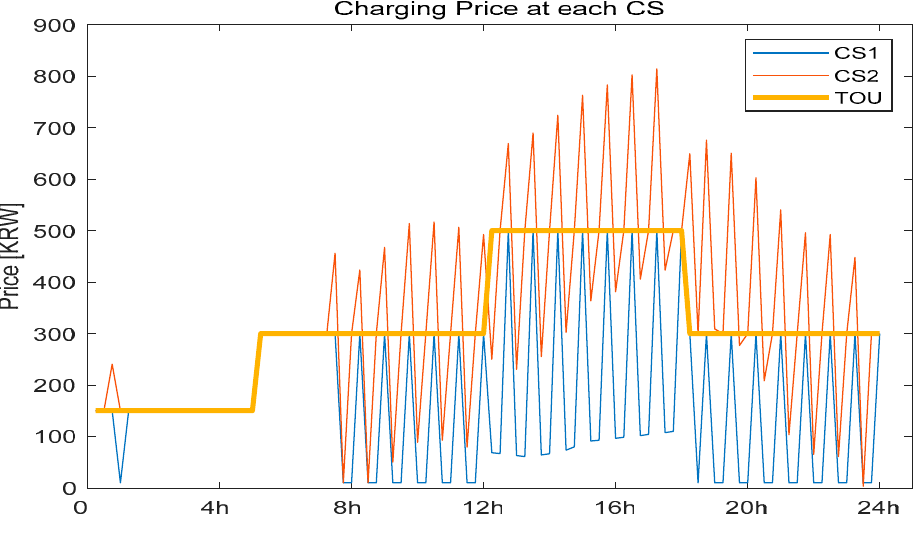
Figure 12. Charging price of CSs in Case 2. Table 3. Summary of simulation results in Case 2.